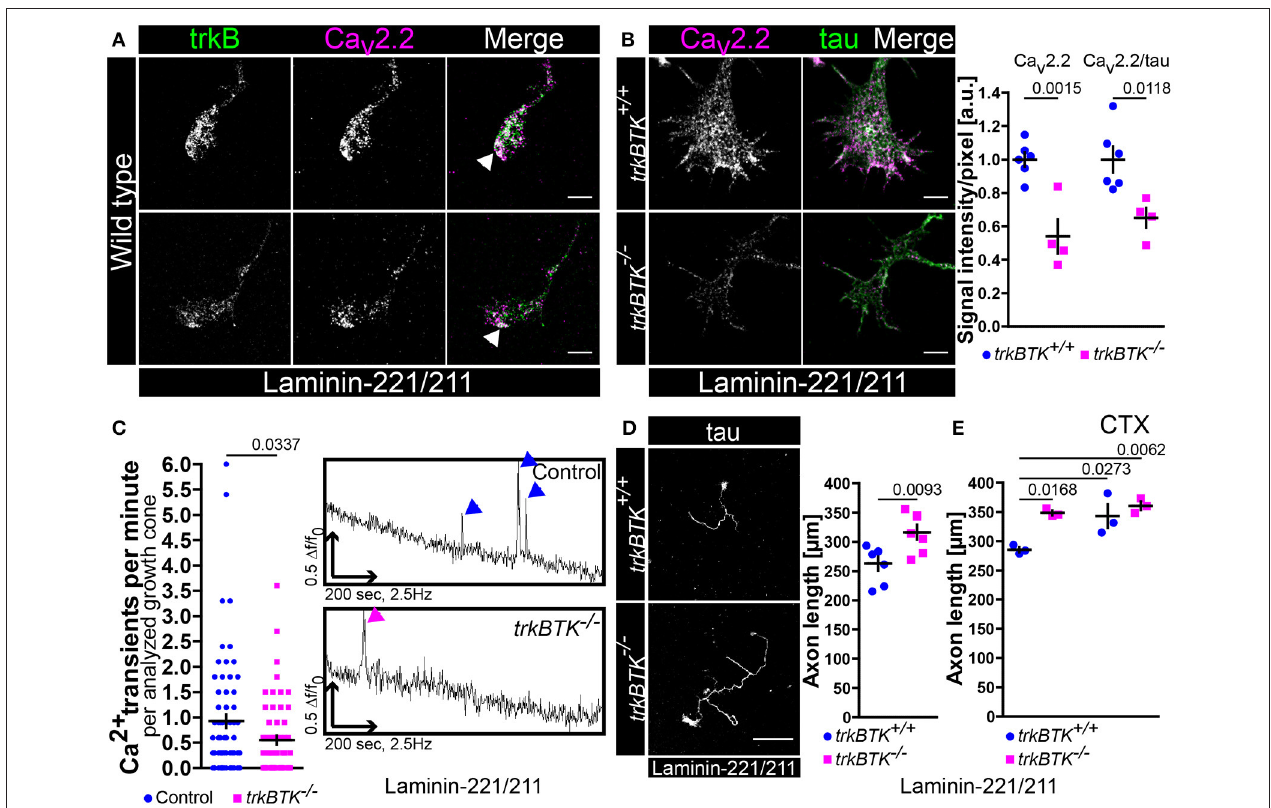
FIGURE 1 | Decrease of Ca v 2.2 accumulations and spontaneous Ca 2 + transients in growth cones of trkBTK − / − motoneurons corresponds to altered axon growth on laminin-221. (A) Representative images of axonal growth cones of wild type motoneurons cultured on laminin-221/211 for 5 days in vitro in the presence of BDNF and CNTF. TrkB receptors (green) and Ca v 2.2 calcium channels (magenta) were closely localized in growth cone protrusions, highlighted by white arrowheads (scale bar: 5 µ m). (B) In trkBTK − / − growth cones Ca v 2.2 accumulation (magenta) was affected in growth cone tips, whereas tau levels (green) were not altered (scale bar: 5 µ m). Statistical analysis of Ca v 2.2 immunoreactivity in trkBTK − / − axonal growth cones (0.54 ± 0.1, Q 2 0.47, n = 4, N = 66) in comparison to wild type controls (1.00 ± 0.04, Q 2 1.01, n = 6, N = 78) revealed a significant difference ( p = 0.0015). Similar findings were obtained by normalizing Ca v 2.2 against the internal reference protein tau ( trkBTK + / + 1.00 ± 0.08, Q 2 0.95; trkBTK − / − 0.65 ± 0.06, Q 2 0.67; p = 0.0118) (C) The structural phenotype was accompanied by significant